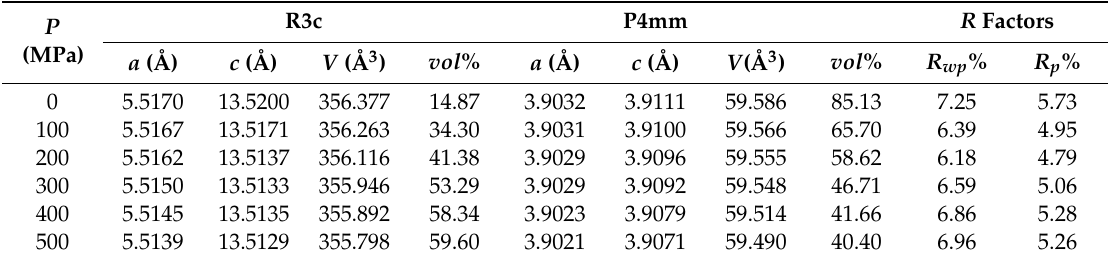
Figure 5. XRD Rietveld refinements of the NKBET20 ceramic powders under various pressures: ( A ) 0, ( B ) 100, ( C ) 200, ( D ) 300, ( E ) 400, and ( F ) 500 MPa. Table 1. The parameter of XRD Rietveld refinement.